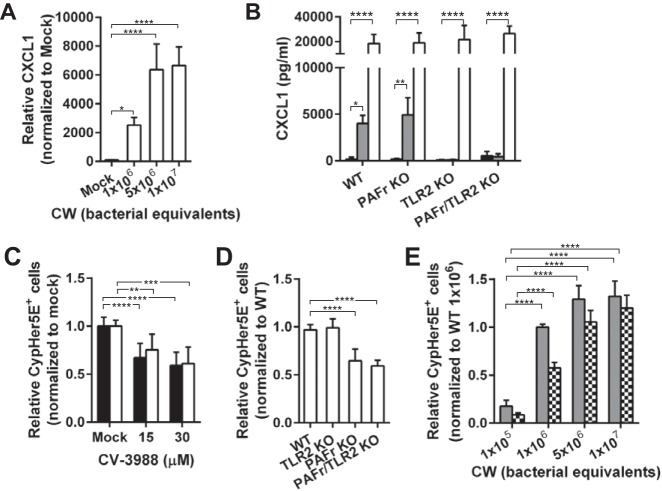
Distinct roles of PAFr and TLR2 during CW exposure. (A) Primary MLEC isolated from wild-type mice (WT MLEC) were incubated with doses of CW as indicated for 8 h at 37°C. The concentration of CXCL1 in the medium was analyzed by ELISA. Data are means plus standard deviations (SD) (error bars) from four independent experiments performed in triplicate. Values that are significantly different by Bonferroni’s multiple-comparison test are indicated by bars and asterisks as follows: *, P < 0.05; ****, P < 0.0001. (B) Primary MLEC from wild-type (WT), TLR2 knockout (TLR2 KO), PAFr knockout (PAFr KO), or PAFr/TLR2 double knockout (PAFr/TLR2 KO) mice were incubated with 107 bacterial equivalents of CW (gray bars) or 5 µg/ml lipopolysaccharide (LPS) from Escherichia coli O111:B4 (white bars) for 8 h at 37°C. LPS, which is a TLR4 ligand, was used as a control to demonstrate that the cells were responsive to inflammation trigger. Untreated controls are depicted as black bars. CXCL1 production was analyzed by ELISA. Data are means plus SD from at least three independent experiments performed in triplicate. *, P < 0.05; **, P < 0.01; ****, P < 0.0001 (Bonferroni’s multiple-comparison test). (C) A549 cells (black bars) and HBMEC (white bars) were continuously treated with dimethyl sulfoxide (DMSO) (Mock) or CV-3988 at the concentration indicated. CypHer5E-labeled CW was added to cells for 2 h at 37°C, and the cells were washed and lifted from the well, and CypHer5E-positive cells were quantitated by flow cytometry. Data are presented as means plus SD from at least three independent experiments. **, P < 0.01; ***, P < 0.001; ****, P < 0.0001 (Bonferroni’s multiple-comparison test). (D) Primary MLEC isolated from WT or KO mice were incubated with CypHer5E-labeled CW, and CypHer5E-positive cells were analyzed as described above for panel C. Data are presented as means plus SD from at least three independent experiments. ****, P < 0.0001 (Bonferroni’s multiple-comparison test). (E) Primary MLEC from WT mice (solid gray bars) or PAFr KO mice (bars with checkerboard pattern) were incubated with the indicated doses of CypHer5E-labeled CW, and CypHer5E-positive cells were analyzed as described above for panel C. Data are presented as means plus SD from three independent experiments. ****, P < 0.0001 (Bonferroni’s multiple-comparison test).